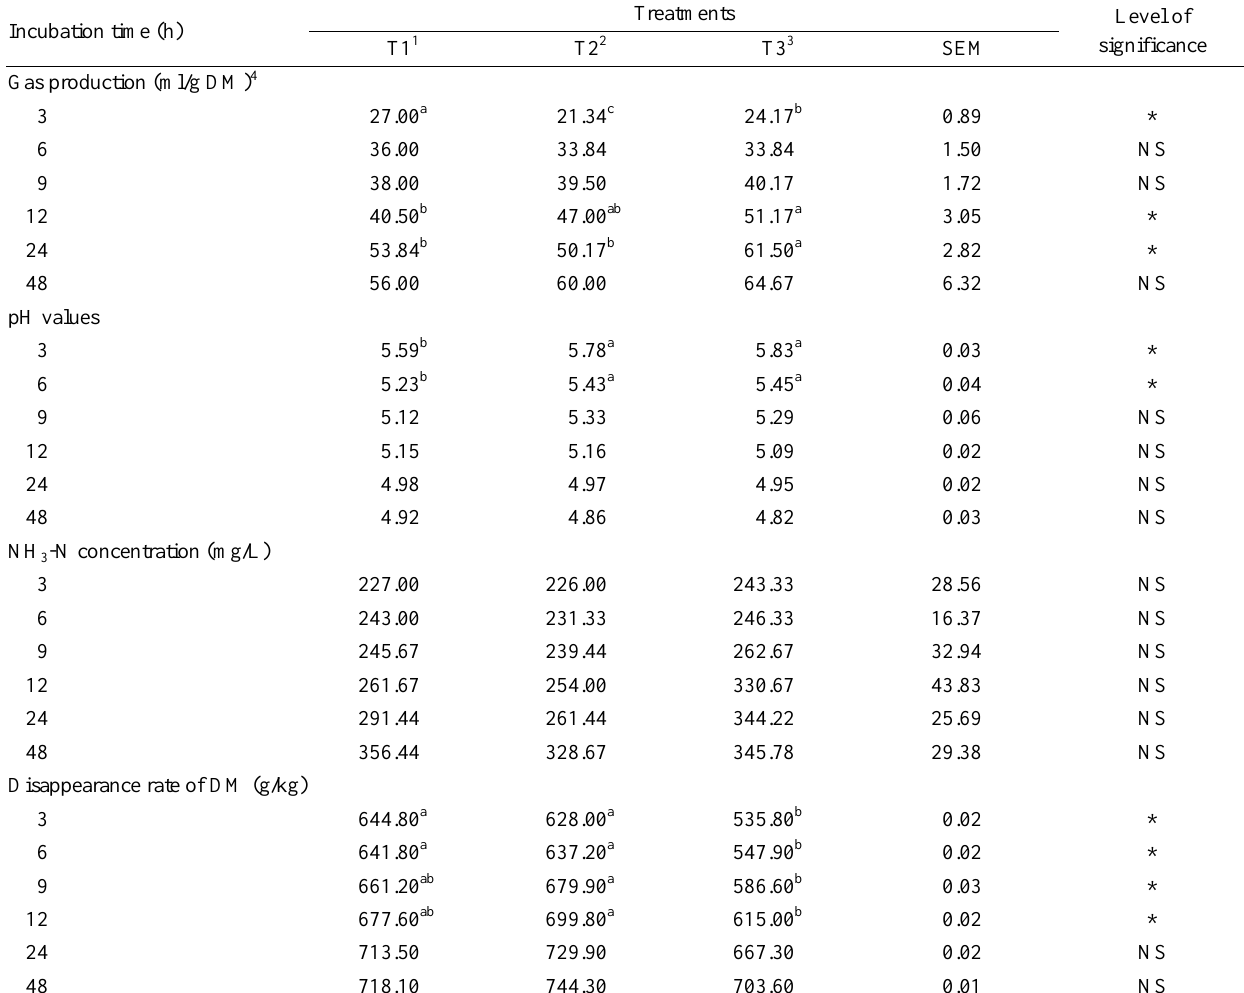
Table 2. Total gas production, pH values, ammonia-nitrogen concentration and disappearance rate of DM in in vitro ruminal fermentation of experimental diets at different stages for Exp.